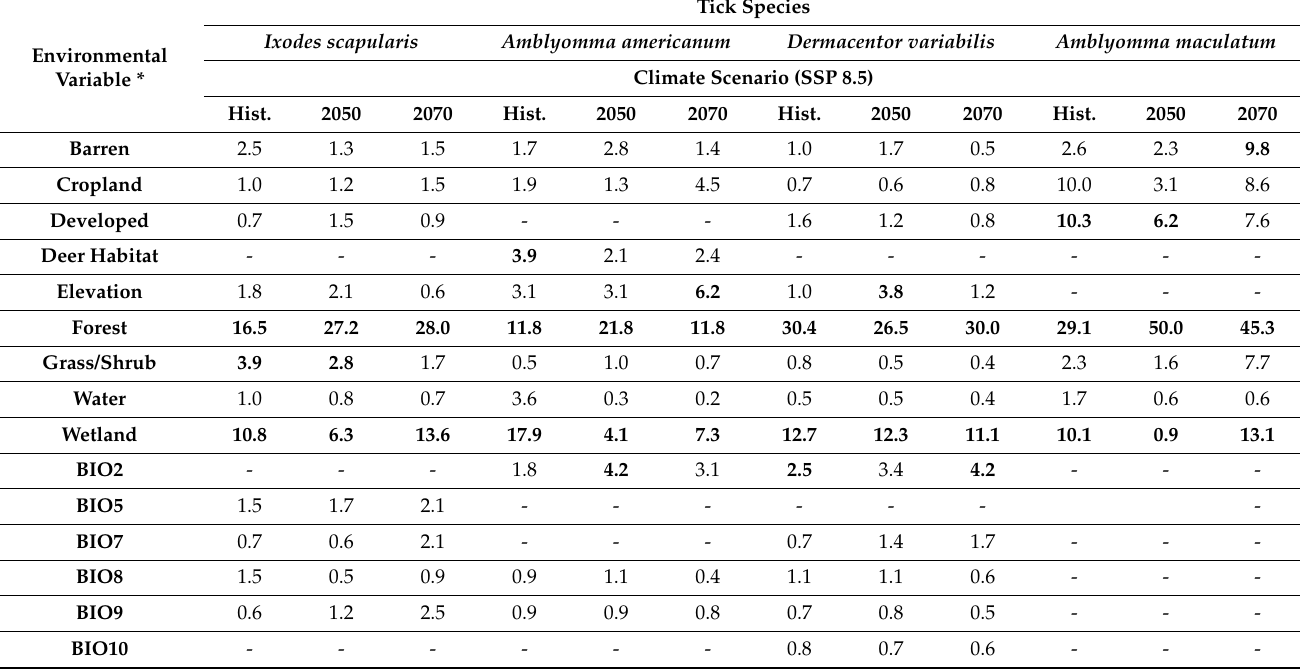
Table 3. Relative percent contribution of habitat suitability variables in best fit models for each tick species across the three climate scenarios. Current climate models were fit using the historical data representing the average climate measurements from 1970 to 2000 at a 1 km resolution. Future climate models were fit with mean projections of these data at a 1 km resolution using Coupled Model Intercomparison Project phase 6 (CMIP6)/ EC-Earth3-Veg Shared Socioeconomic Pathway (SSP) 8.5 for 2050 (average from 2041 to 2060) and 2070 (average from 2061 to 2080). All landscape variables represent the percentage of that landcover, except for elevation, which is measured in meters. The top three most important variables in the model prediction are bolded for each period. Variables that were not included in a model due to collinearity are denoted with a